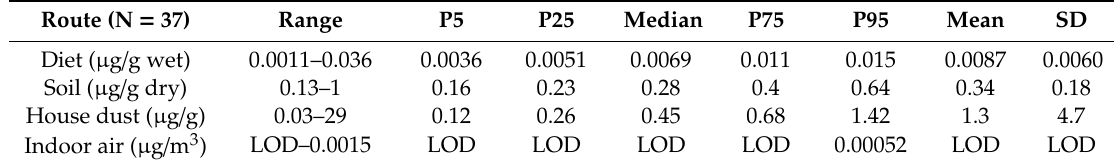
Table 2. Summary on Cd concentrations according to the exposure route.